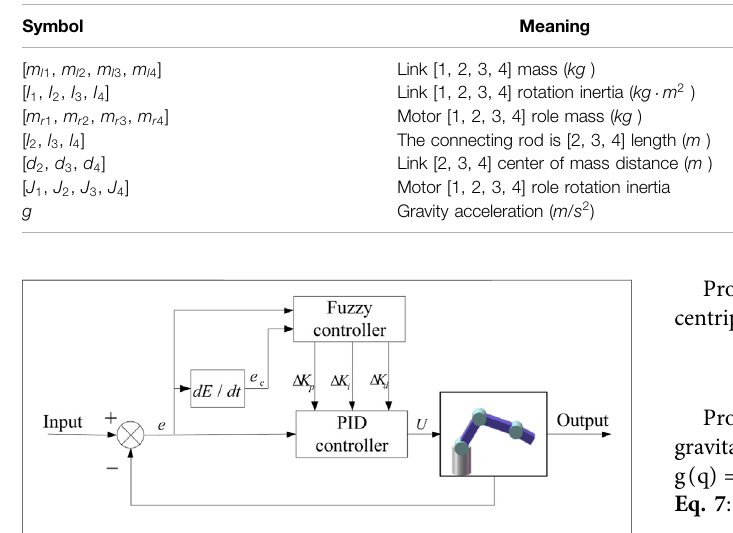
TABLE 1 | Manipulator parameter values.